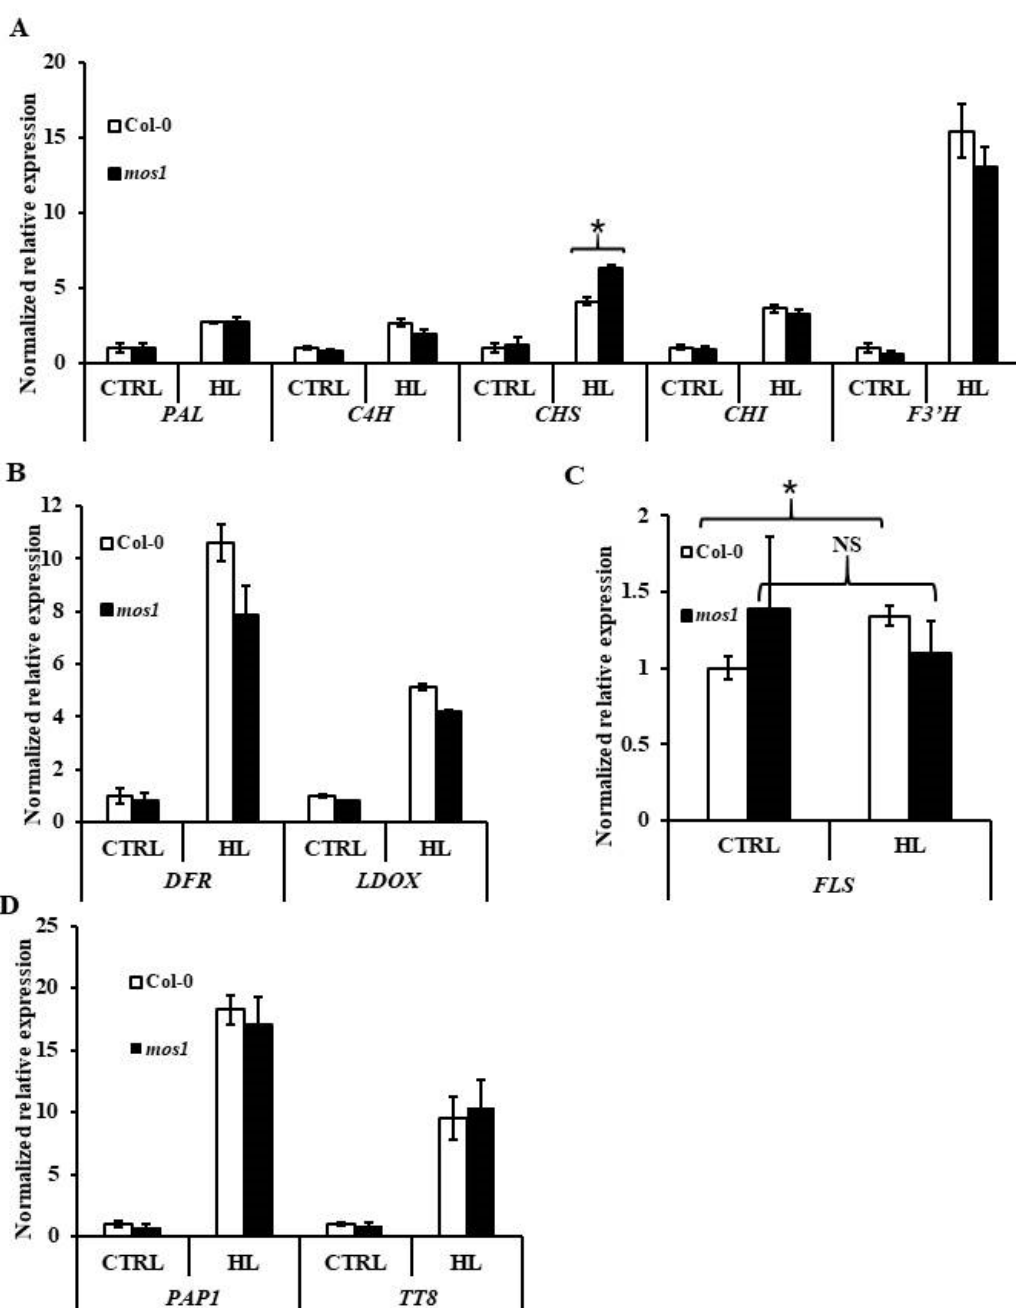
Figure 7. Expression analysis of anthocyanin biosynthesis genes in response to light. qRT-PCR analysis of the expression of early ABG s ( A ), late ABG s ( B ), FLS ( C ), and TFs ( D ) in 14-d-old Col-0 and mos1 seedlings grown on soil under normal (CTRL) or 24 h high-light (HL) treatment. Quantification was normalized to ACTIN2 . Error bars indicate SE of two independent biological replicates. The asterisks indicate significant di ff erences compared with the corresponding Col-0 (one-way ANOVA / Bonferroni p < 0.001). NS, not